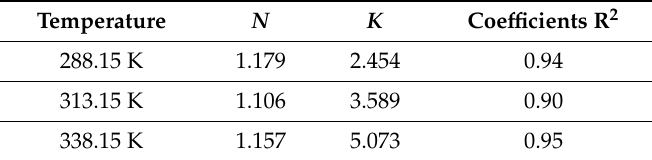
Table 3. Values of constants n and K of Freudlich isotherms for WD (HCl).